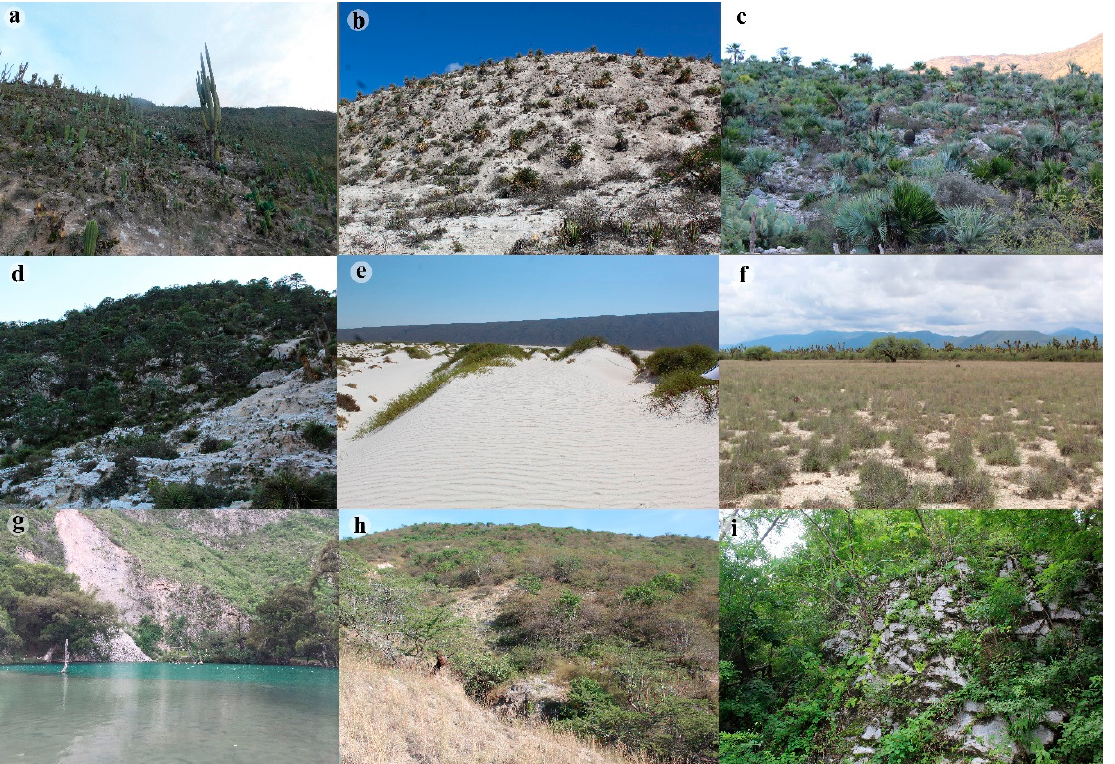
Figure 1. Vegetation types in gypsum soils of Mexico: ( a ) xerophilous scrubland in San Juan Teita, Oaxaca, ( b ) xerophilous scrubland in Aramberri, Nuevo León, ( c ) palmetto woodland in Galeana, Nuevo León, ( d ) coniferous forest in Galeana, Nuevo León, ( e ) dune vegetation in Cuatro Cienégas, Coahuila, ( f ) grassland in Vanegas, San Luis Potosí, ( g ) tropical deciduous forest in Santiago Jux- tlahuaca, Oaxaca, ( h ) grassland and tropical deciduous forest in Tolimán, Jalisco, and ( i ) tropical deciduous forest in Tecomán, Colima. Photographs: ( a ) Juvenal Aragón, ( b – i ) J. P. Ortiz-Brunel.